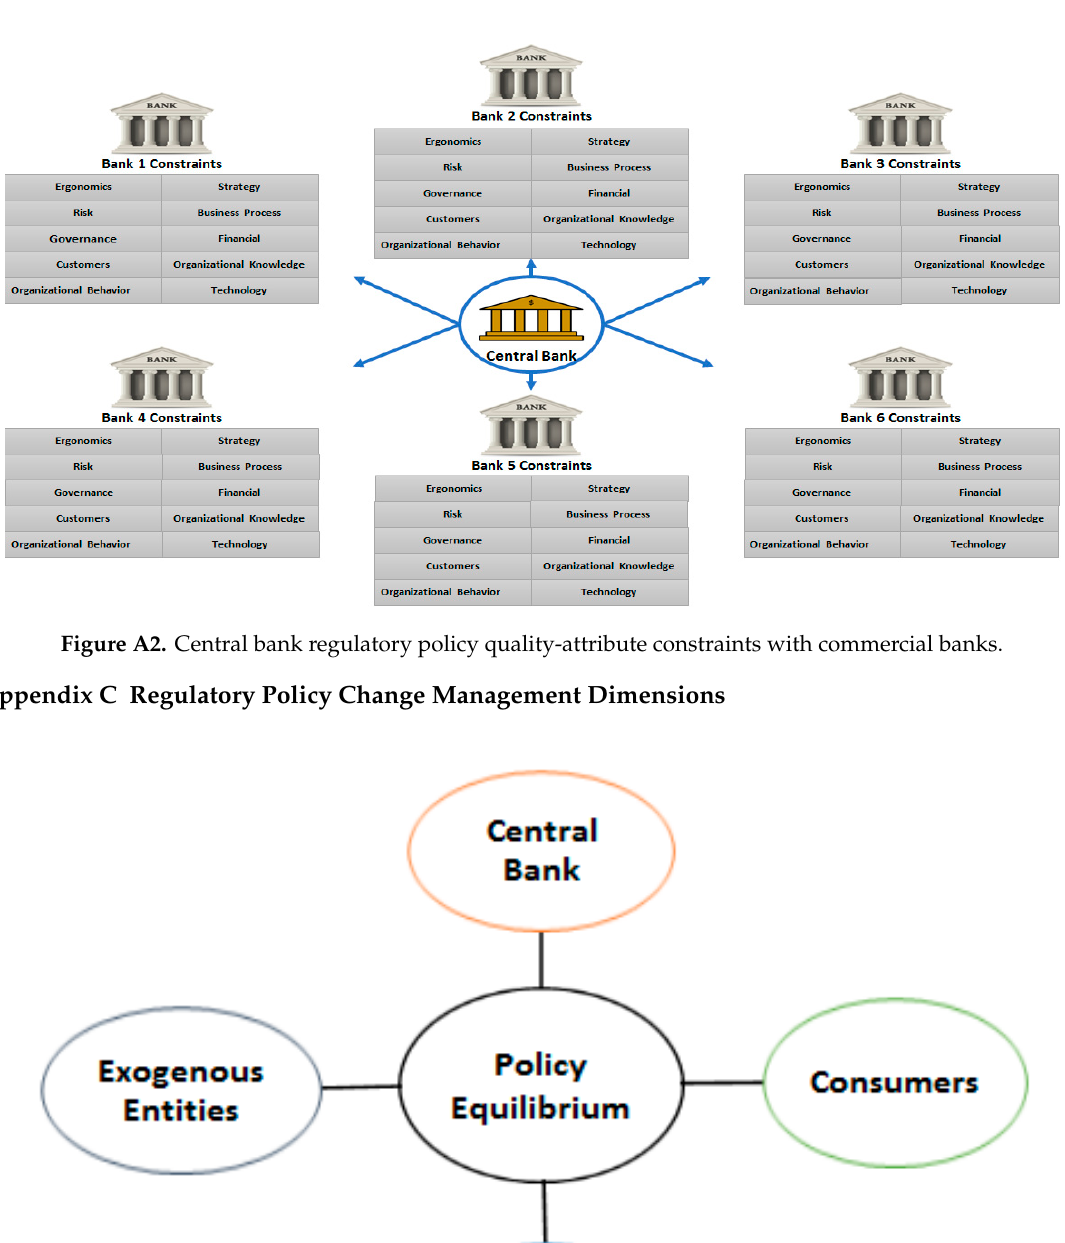
Figure A3. Regulatory policy change management dimensions.